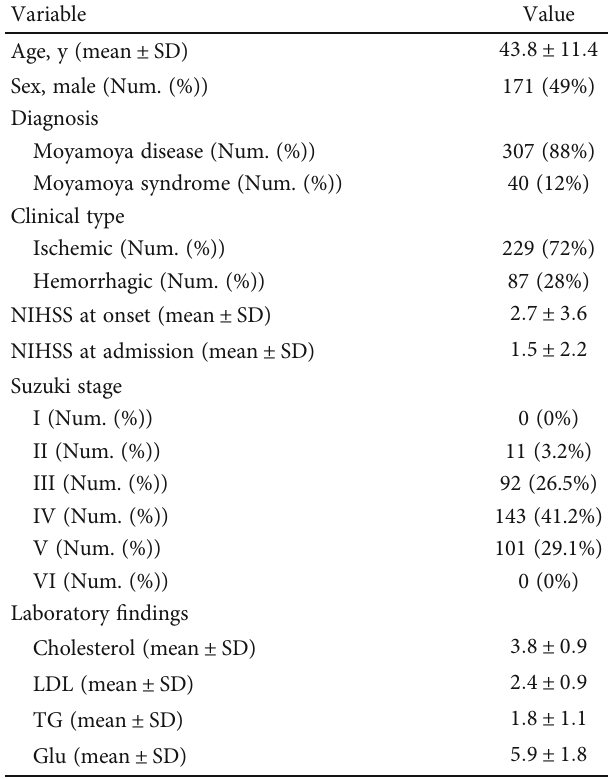
Table 1: Demographics and baseline characteristics of patients with